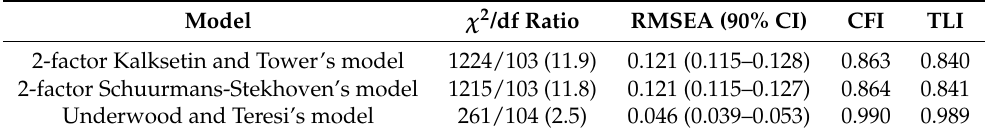
Table 2. Goodness-of-fit for the three DSES factor models tested in the study in Sample 2. Model